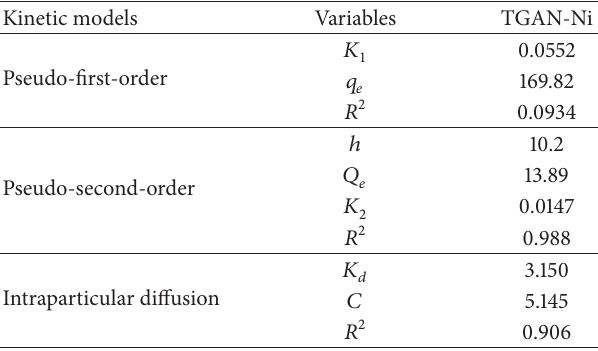
Table 4: The correlation coefficients of kinetic parameters for the adsorption of Ni (II) ions onto TGAN.